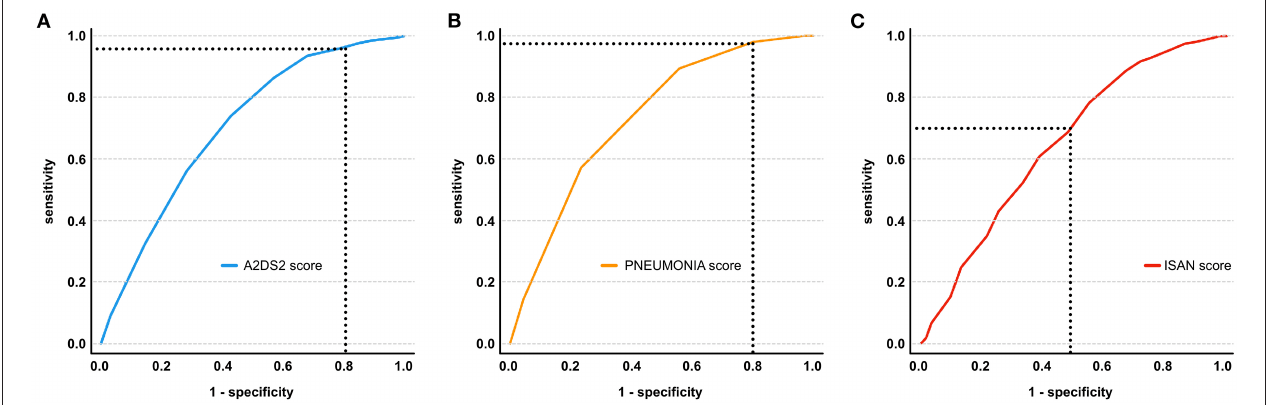
FIGURE 2 | Receiver operating characteristic (ROC) curve illustrating the performance of A 2 DS 2 (A) , PNEUMONIA (B) , and ISAN scores (C) in the prediction of PSP in AIS due to large vessel occlusion of the anterior circulation. The optimal sensitivity and 1 - specificity of the scores based on the ideal cutoff value derived from the ROC analysis are illustrated by the dashed